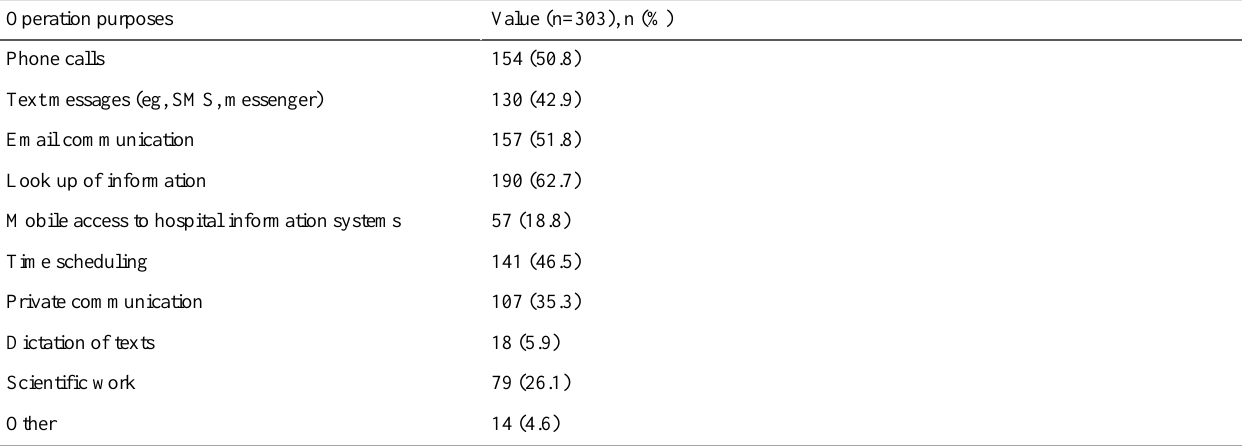
Table 3. For which operation purposes do you use mobile devices in your clinical